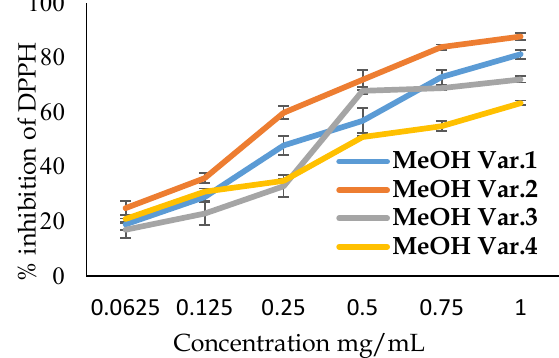
Figure 4. DPPH radical scavenging activity of fig flowers fruits methanolic extracts. MeOH Var.1; MeOH Var.2 : Variety 1, 2 Bakor (Fig flowers) of Bechar. MeOH Var.3; MeOH Var.4 : Variety 3, 4 Bakor